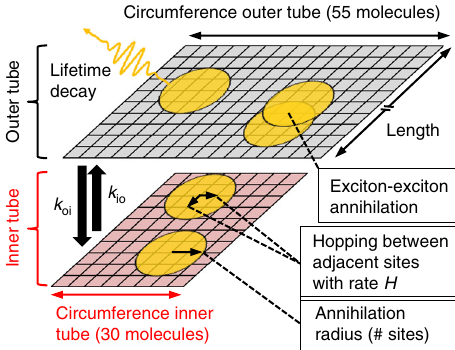
Supplementary Fig. 22. In brief, the output of a Ti:Sapphire-Laser (Spit fi re Pro, Spectra Physics, 1kHz repetition rate) was focused into a fused-silica hollow-core fi ber (UltraFast Innovations) fi lled with argon to generate a broadband white-light continuum. The main fraction of the light was used as the pump beam and guided